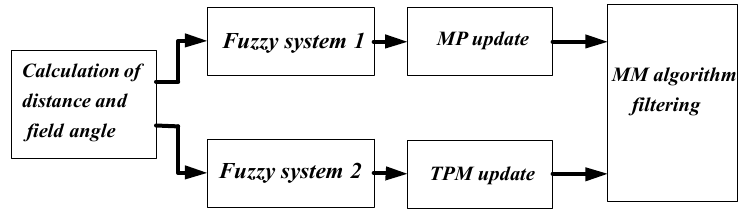
Figure 3. The schematic block diagram of the fuzzy-logic-based obstacle information-aided multiple-model (FOIA-MM) algorithm.